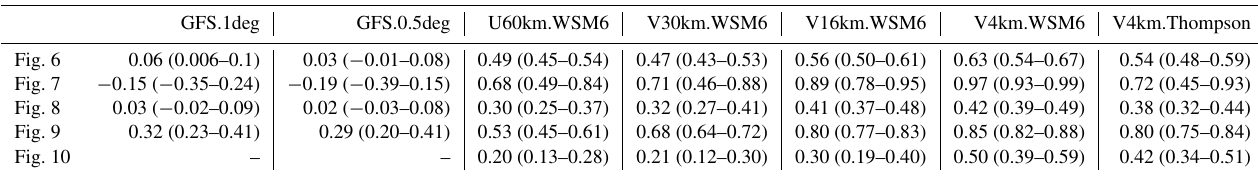
Table 3. The correlation coefficients and the corresponding 95% confidence intervals based on the bootstrap analysis for the results shown in Figs. 6–10.